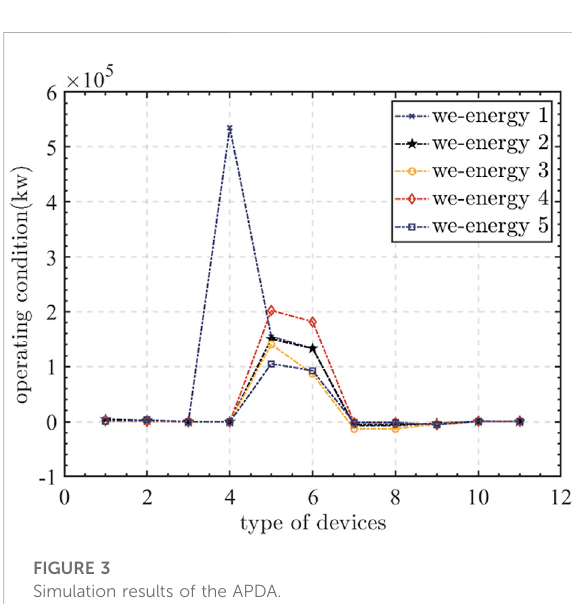
FIGURE 3 Simulation results of the